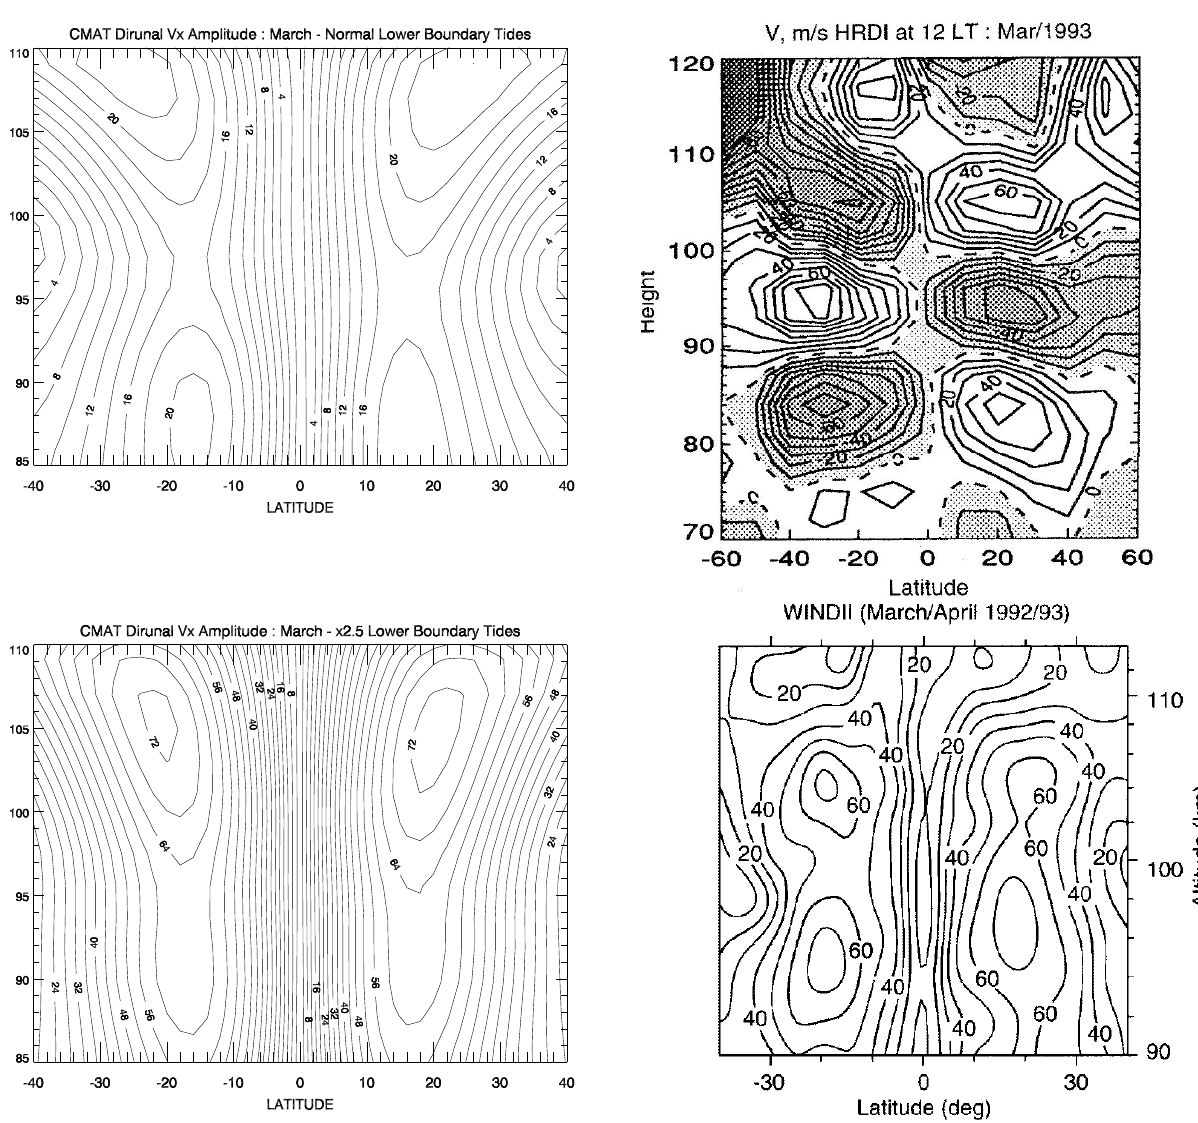
Fig. 4. Diurnal amplitude structure of meridional winds (ms − 1 ) as calculated by CMAT for March, with normal lower boundary tidal forcing (top), and × 2 . 5 lower boundary tidal forcing (bottom).